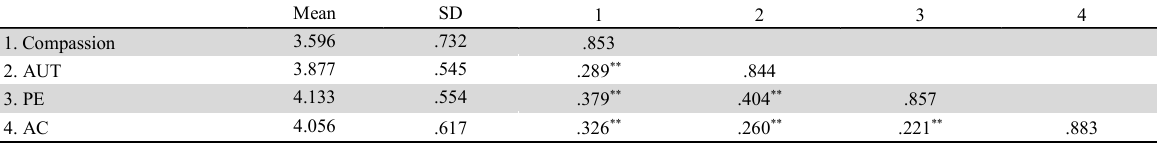
Correlation Analysis Result